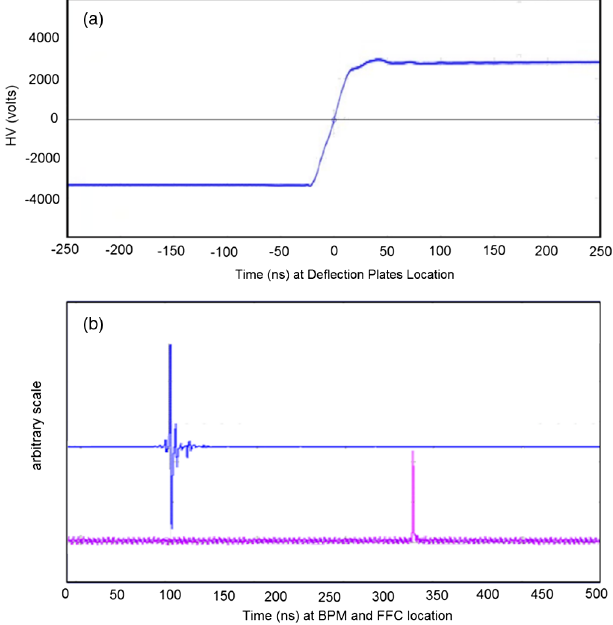
bunches.FIG. 8. (a) Oscilloscope trace of HVapplied to deflector plates. The fast chopper trigger initiates a 30 ns HV switch from − 3 . 25 to þ 2 . 75 kV. (b) Detectors response following fast chopper trigger. The blue trace is signal induced on the BPM situated in the MEBT, and the purple trace is beam induced signal on the FFC situated in the D-plate (averaged over four